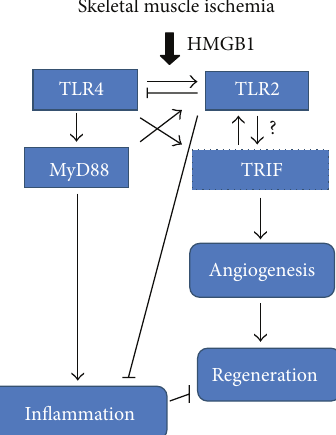
Figure 1: Proposed pathway connecting HMGB1, TLR4, TLR2, MyD88, and TRIF signaling to inflammation and regeneration following muscle ischemia. We have shown that HMGB1 is released from ischemic myocytes and TLRs 2 and 4 have opposing roles fol- lowing hindlimb ischemia. This proposed mechanism demonstrates the interplay between TLR4, TLR2, MyD88, and TRIF in response to skeletal muscle